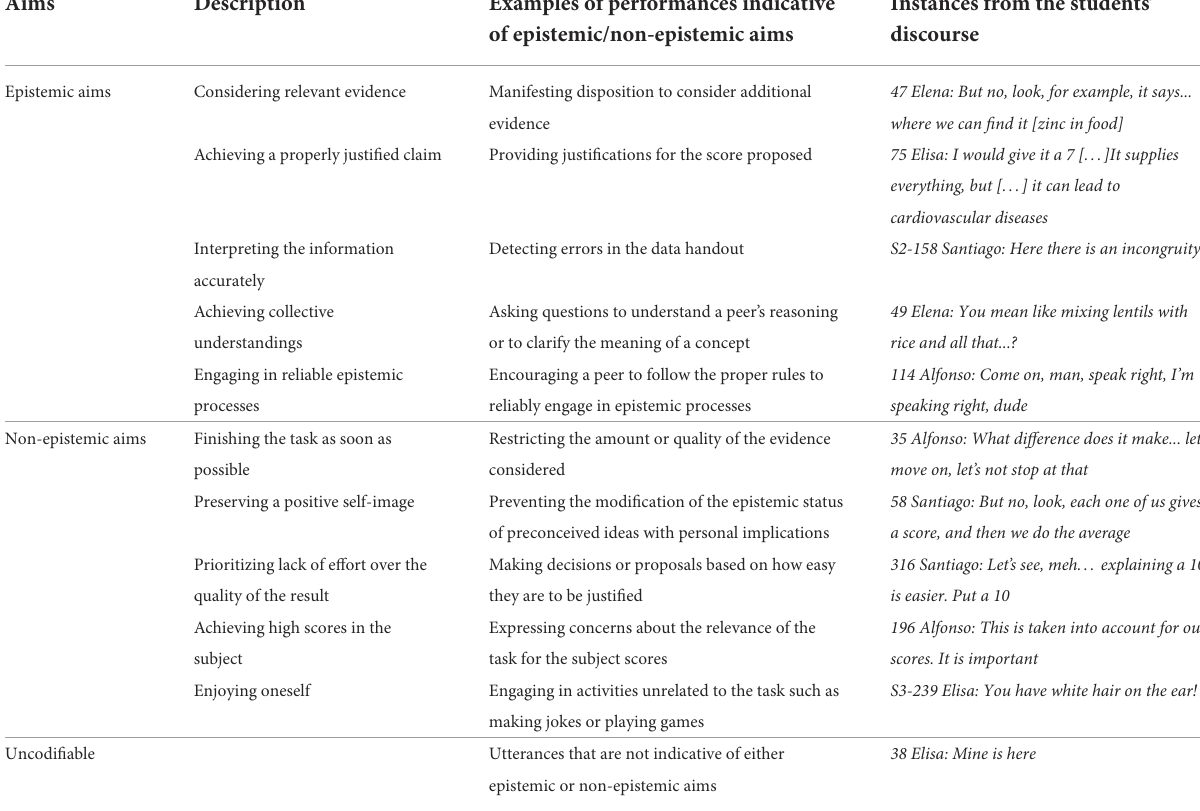
TABLE 1 Coding categories for epistemic and non-epistemic aims and students’ performances indicative of them.